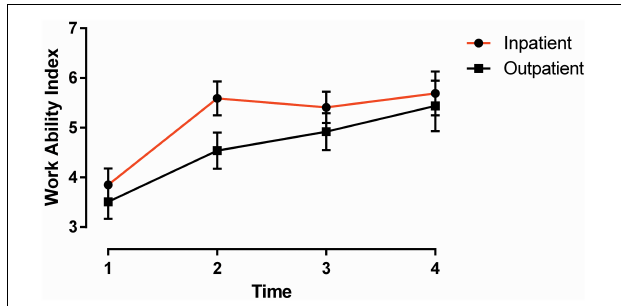
FIGURE 2 | Work Ability Index: group by time. Vertical bars denote 1 S.E.M.